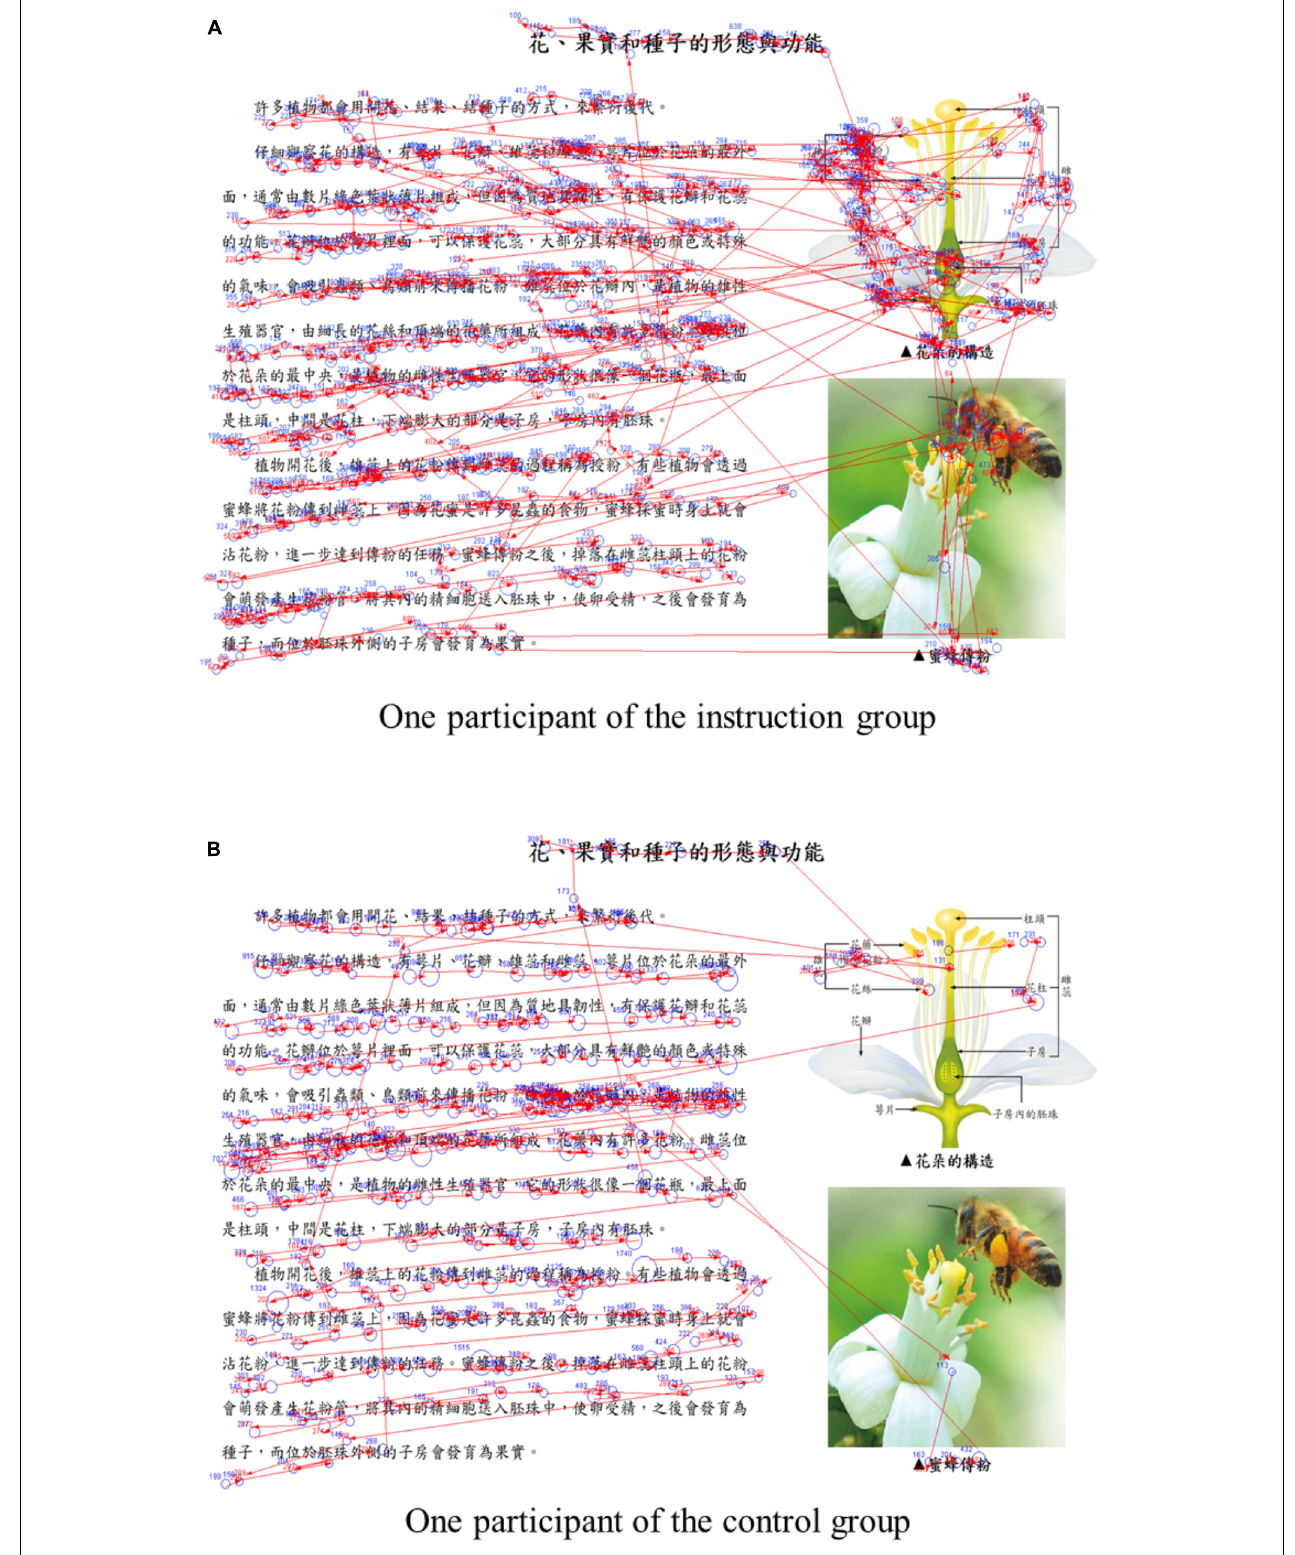
FIGURE 1 | Eye movements of two participants. (A) Participant A belonged to the instruction group and (B) participant B belonged to the control group.